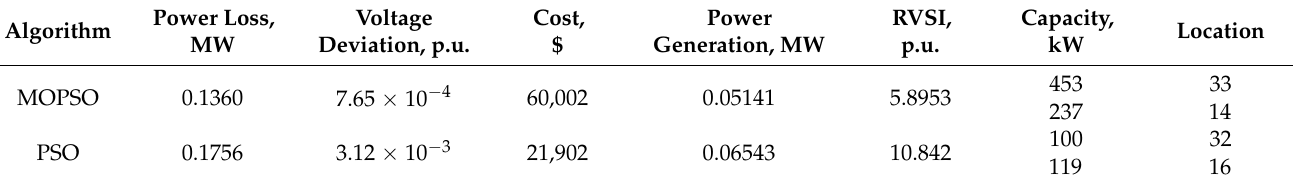
Table 10. Comparison of the results of MOPSO algorithm and PSO algorithm (two BESSs